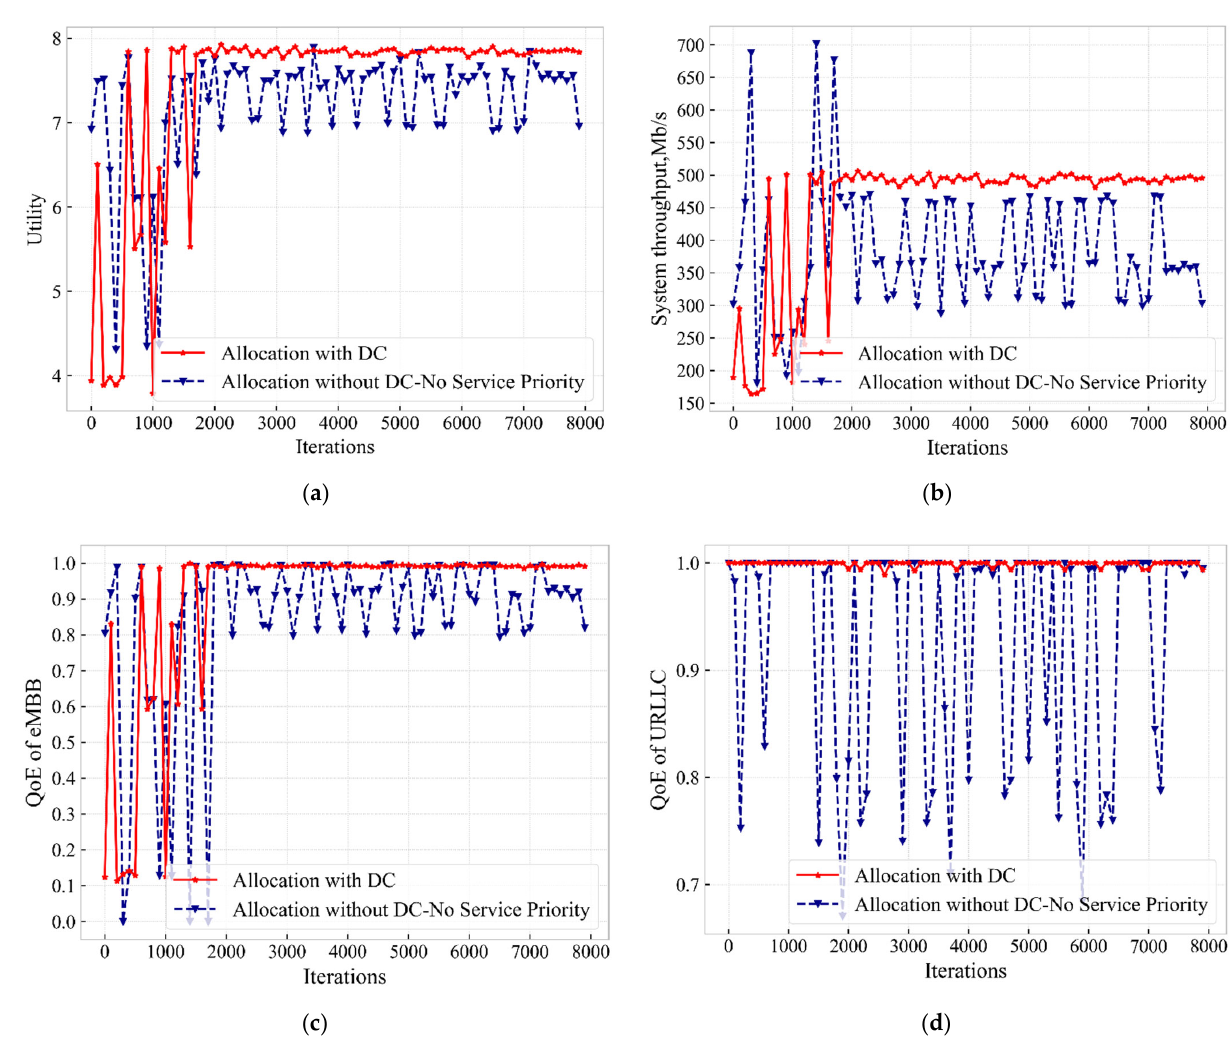
Figure 7. The comparison of optimization goals under the LSTM-D3QN algorithm with and without dual connectivity assistance while there is no service priority. ( a ) The comparison of utility; ( b ) the comparison of system throughput; ( c ) the comparison of QoE of eMBB; ( d ) the comparison of QoE of URLLC.